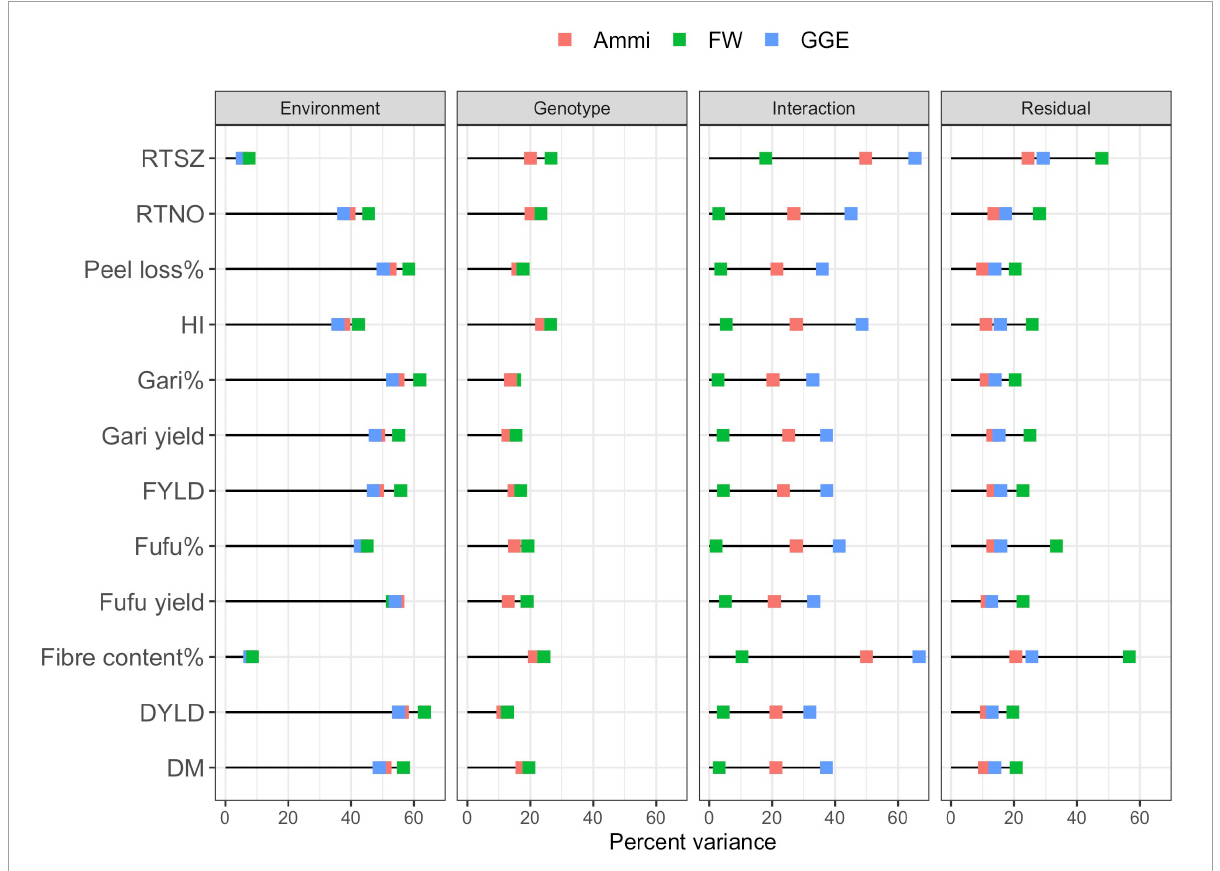
FIGURE6 Partitioning of total sum of square (TSS) based on total sum of squares captured by each factor from fitting additive main effect and multiplicative interaction (AMMI) (represented by the orange square), Finlay Wilkinson (FW) (represented by green square), and genotype and genotype by environment (GGE) (represented by blue square) models on 67 elite cassava genotypes evaluated in 8 environments. DM, Drymatter; RTNO, Root number; DYLD, Dry root yield; FYLD, Fresh root yield; HI, Harvest index; RTSZ, Root